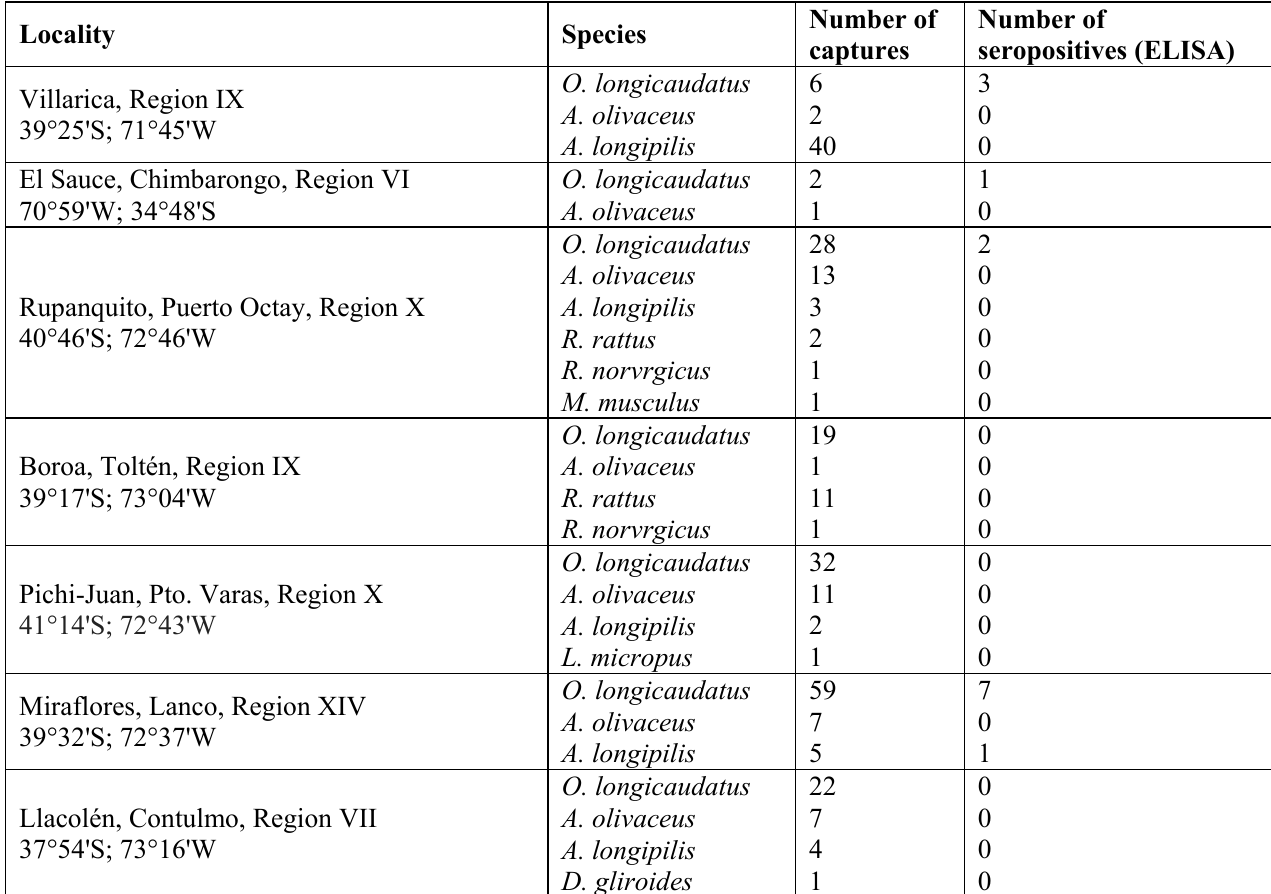
Table 1. Sampled sites, and seropositivity of rodent species captured in the sampling period (2011–2013).